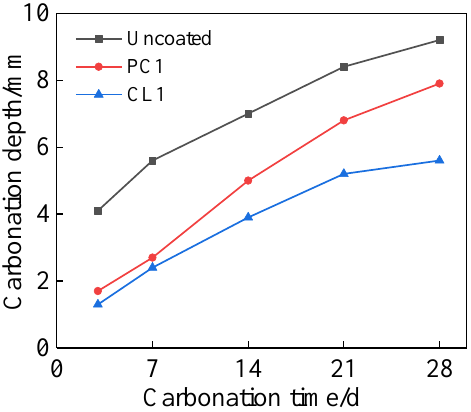
Figure 6. E ff ect of coatings onthe carbonation depth of Figure 6. Effect of coatings onthe carbonation depth of specimens. Figure 6. Effect of coatings onthe carbonation depth of specimens.